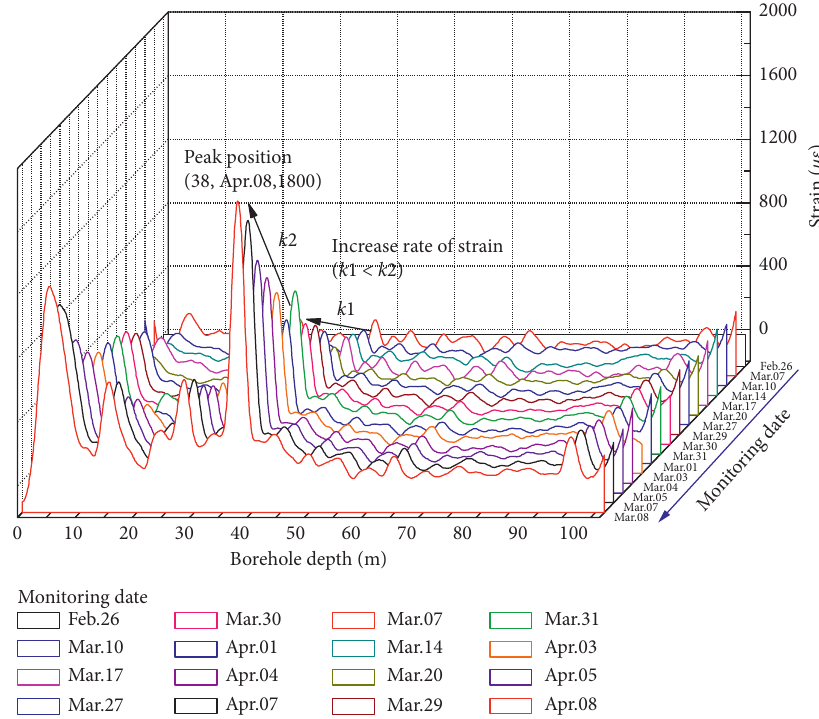
Figure 4: Spatiotemporal evolution diagram of the strain of optical cables in the working face.